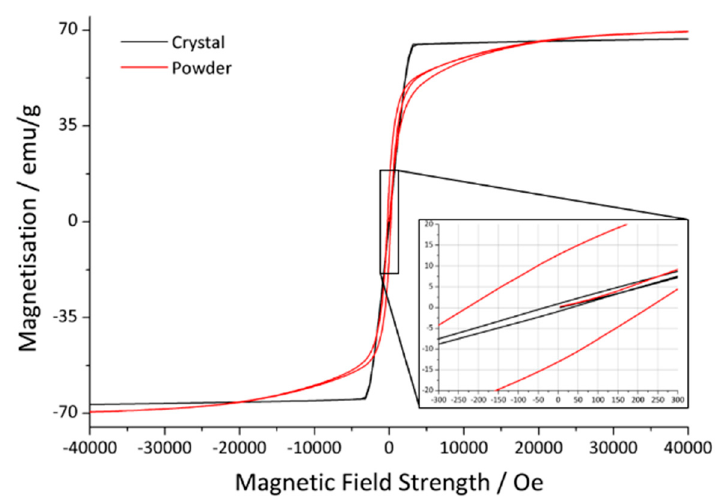
Figure 4. Hysteresis curve of a crystal (black) and a powder sample (red). The zoomed in part emphasizes the coercivity and the remanence.